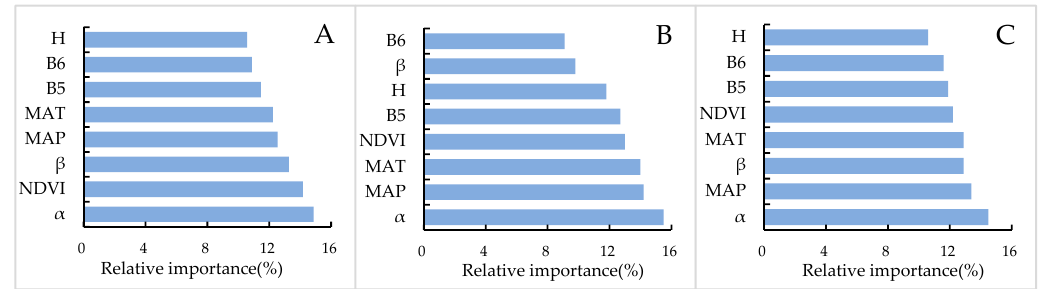
Figure 6. Relative importance of the environmental variables in the prediction of wetland soil organic carbon concentration (SOCc) at different soil depths: ( A ) 0–30 cm, ( B ) 30–60 cm, and ( C ) 60–100 cm.